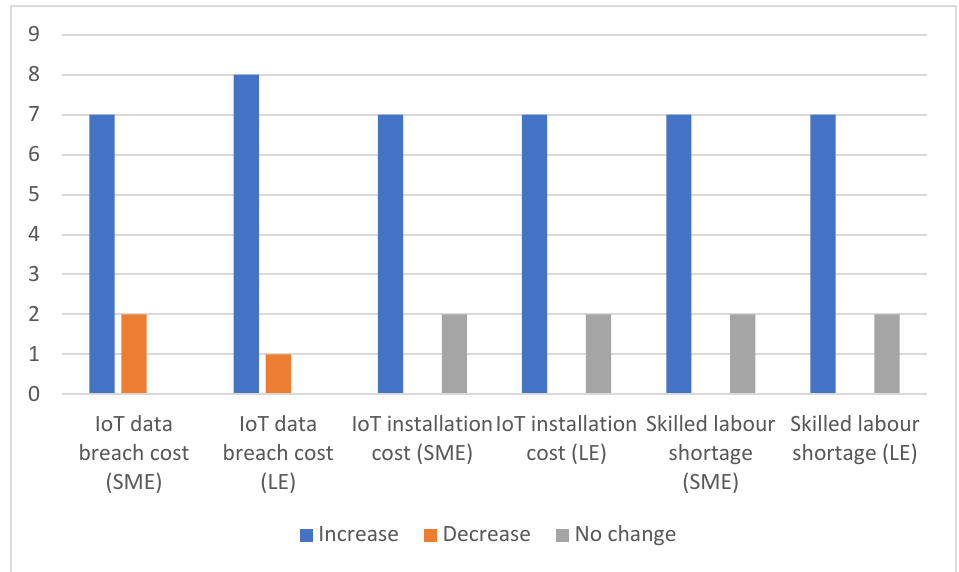
Figure 4. Participants’ responses on data breach costs, installation costs, and skilled labour shortage metrics related to IoT systems for SMEs and LEs.